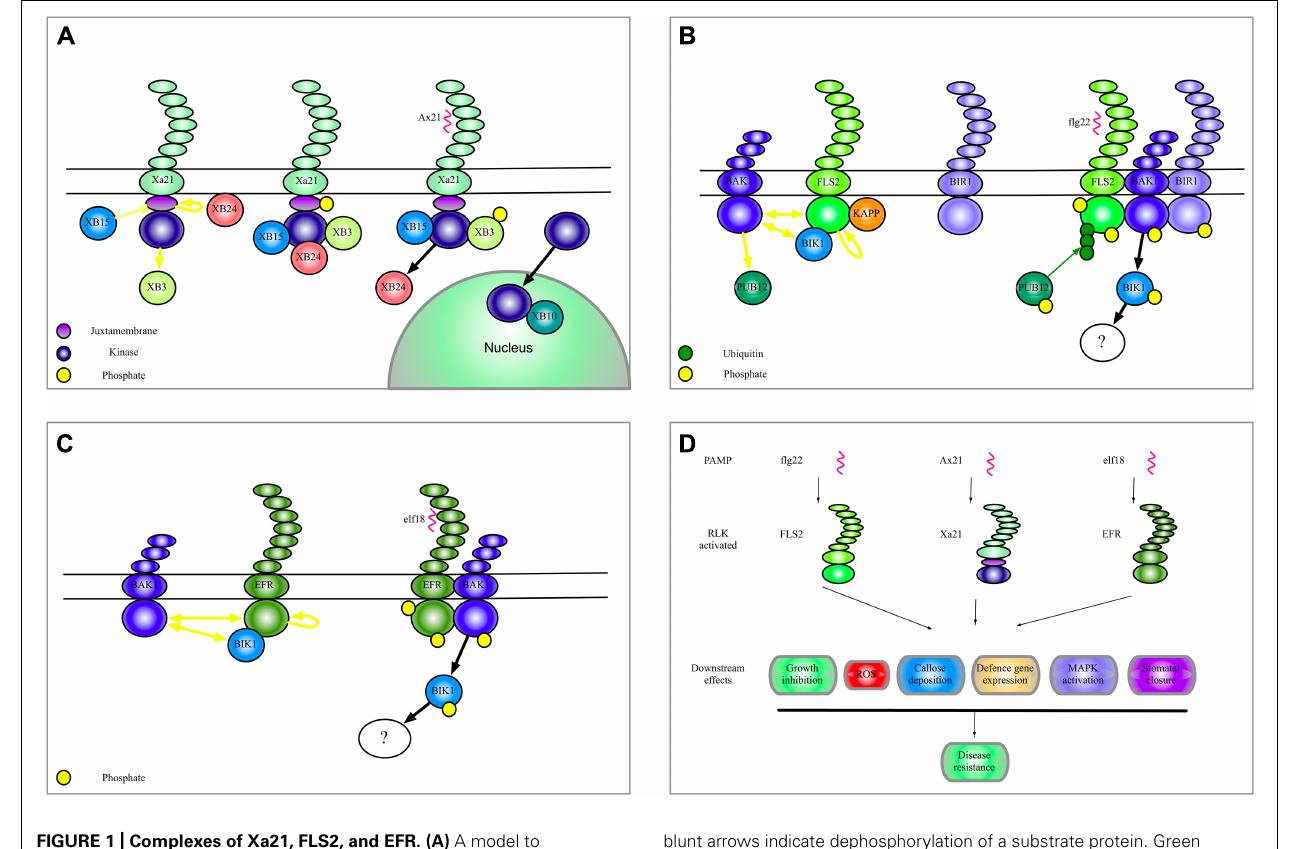
FIGURE 1 | Complexes of Xa21, FLS2, and EFR. (A) A model to summarize the current data regarding Xa21 function as discussed in this manuscript. (B) Illustration of the complexes formed by the RLK-FLS2.The yellow dots indicate phosphorylation of a protein. Yellow arrows indicate phosphorylation of a substrate protein.Yellow